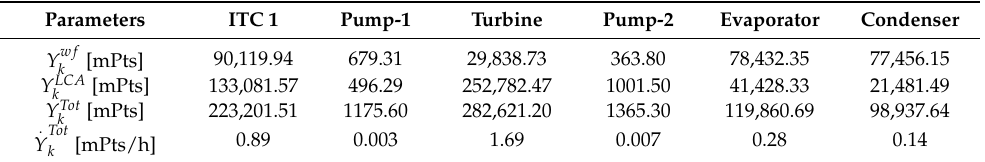
Table 13. Total environmental impacts for each component over its lifetime.